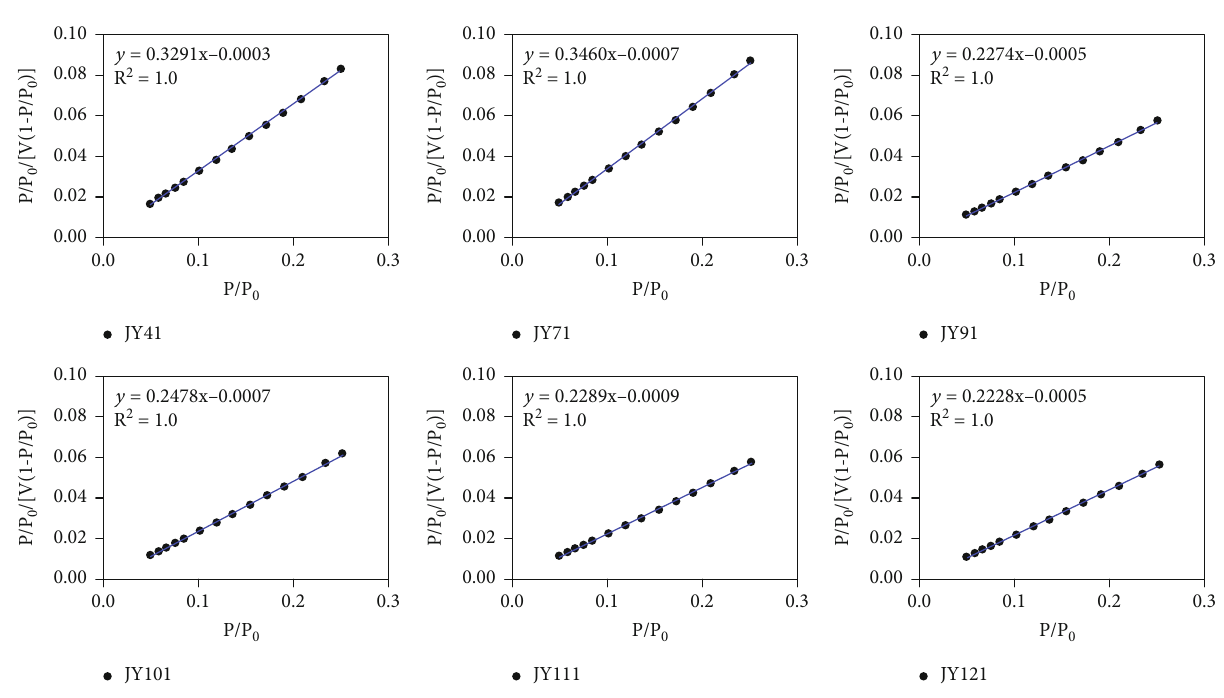
Figure 2: BET plot of the studied gas